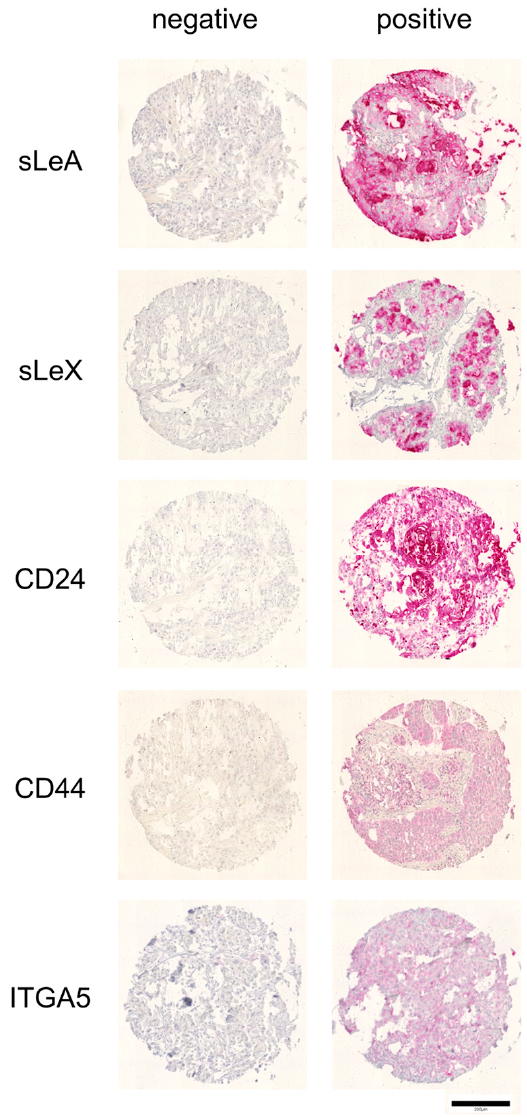
Figure 6. Representative negative and positive tumor samples of immunohistochemical stains of the tissue microarrays (TMA). Scale bar: 200 µm.